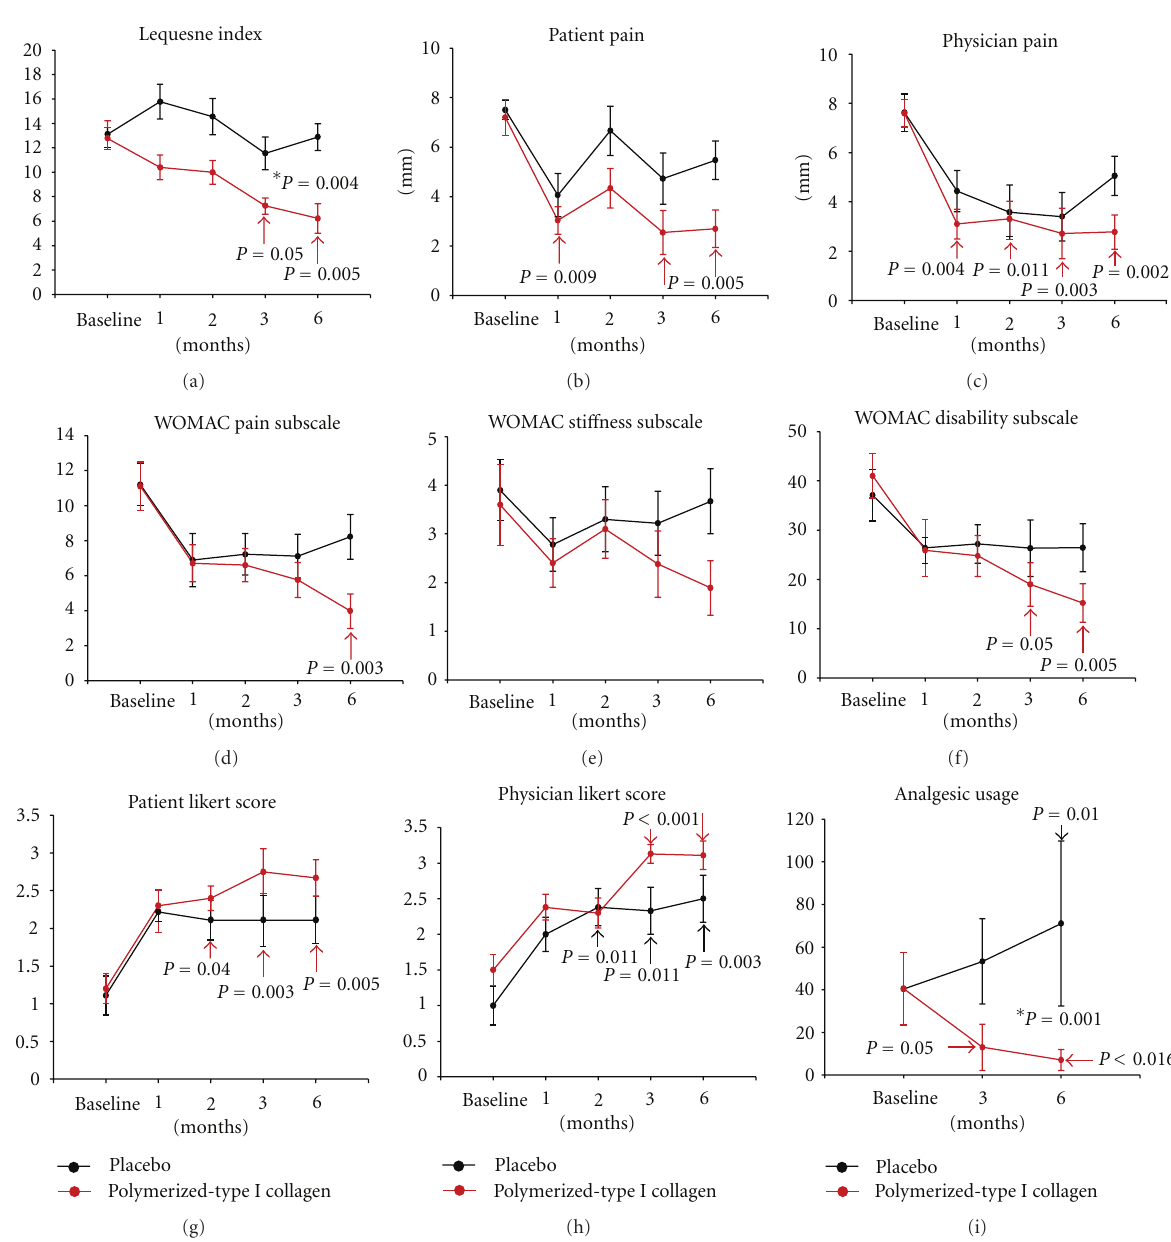
Figure 1: Primary and secondary measures of e ffi cacy. Clinical evaluation was performed at baseline and every month during the study. The primary endpoints included (a) Lequesne index, (b) patient pain visual analogue scale (VAS), (c) physician pain visual analogue scale (VAS), (d) WOMAC pain subscale, (e) WOMAC sti ff ness subscale, (f) WOMAC disability subscale, (g) patient’s and (h) physician’s global assessment of disease activity on a 5-point rating scale, global assessment of change in disease activity at the end of the treatment (Likert score: 0 = very poor; 1 = poor; 2 = fair; 3 = well; 4 = very well), (i) consumption of NSAIDs tablets per month. Arrows depict the month in which the treatment reached a P < 0 . 05 compared to baseline, in black for placebo and in red for polymerized collagen group. Results represent mean ± SD. P values indicate statistical significant di ff erences between treatment